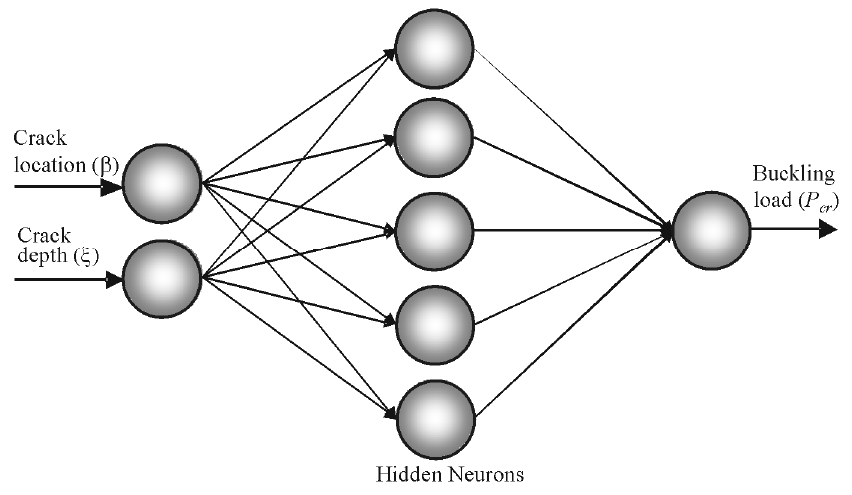
Fig. 4. Artificial neural network architecture used in this